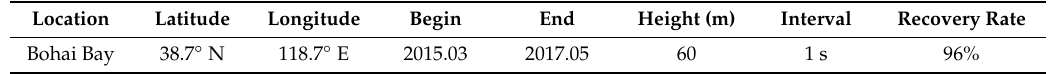
Figure 2. Bohai Bay and the location of the floating production storage and offloading (FPSO) unit (from Google Earth). Table 1. Wind data collected by the measurement sensors.